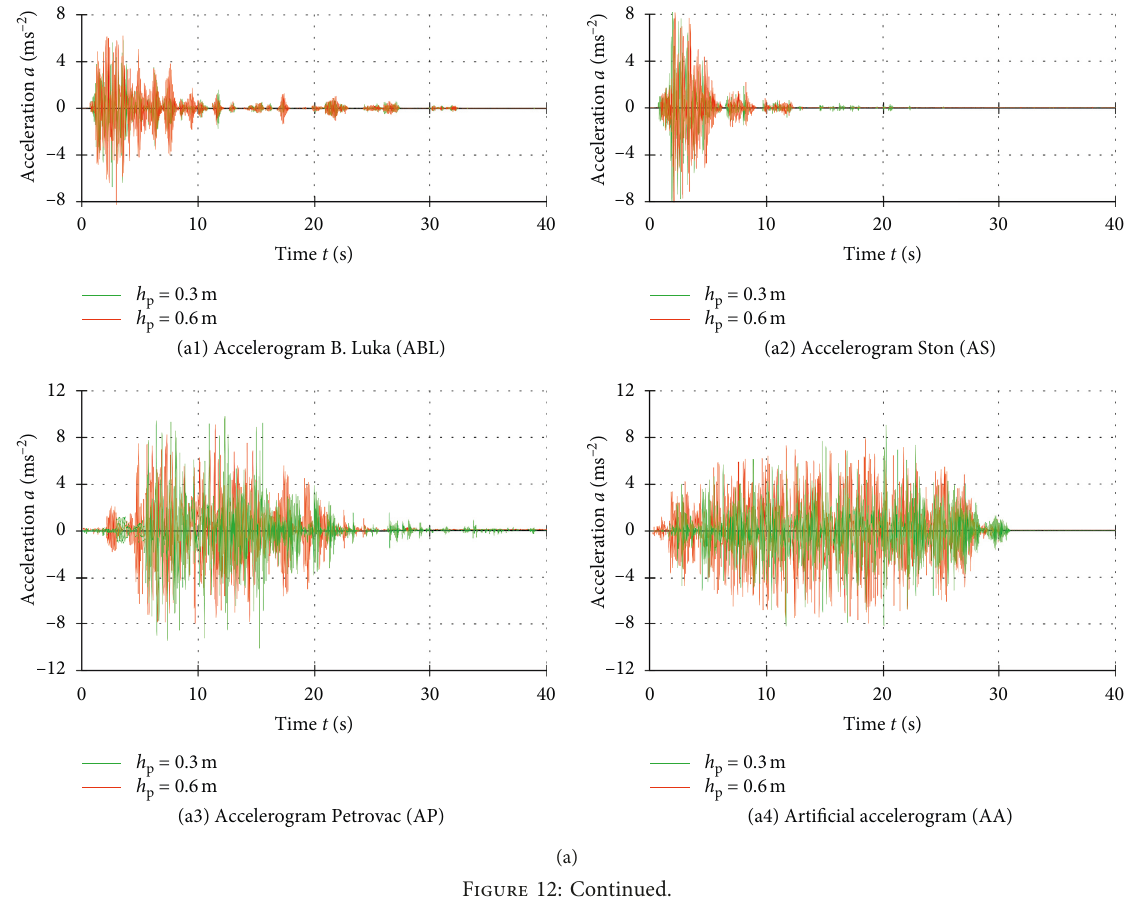
� 0.2g. (b) PGA � 2 . (a) PGA